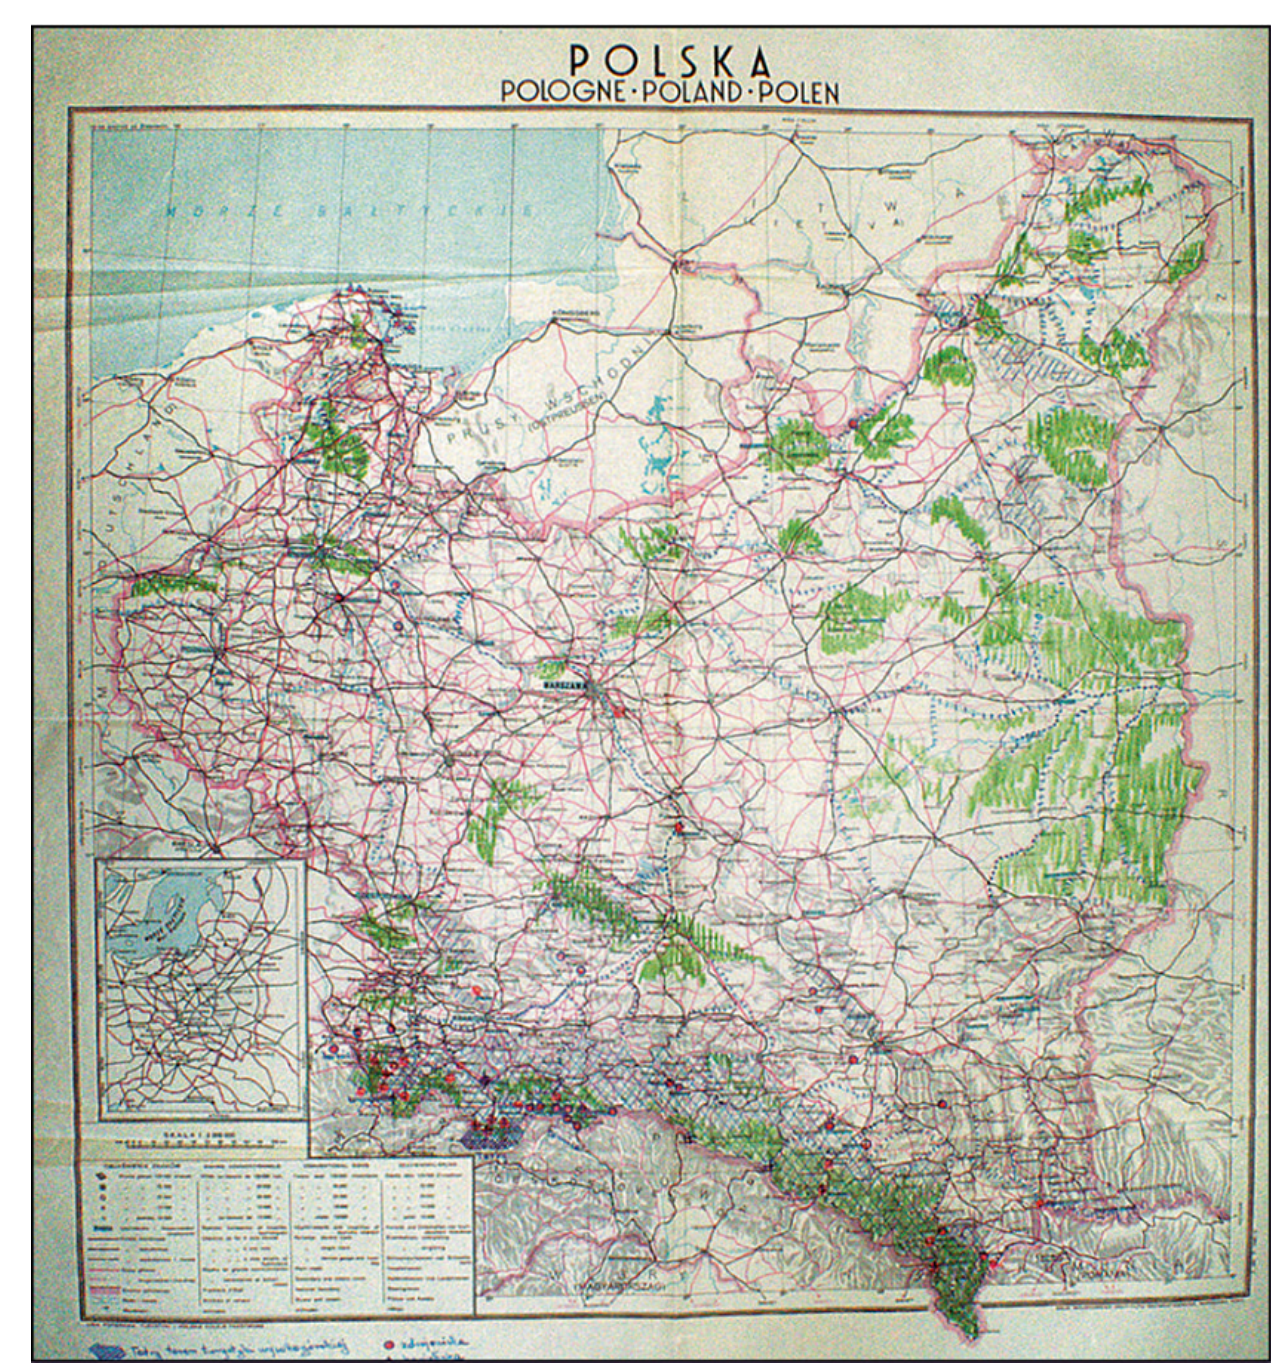
Figure 3. Map of tourist attractions in Poland. Author: Stanisław Leszczycki, handmade (source: the archives of Antoni